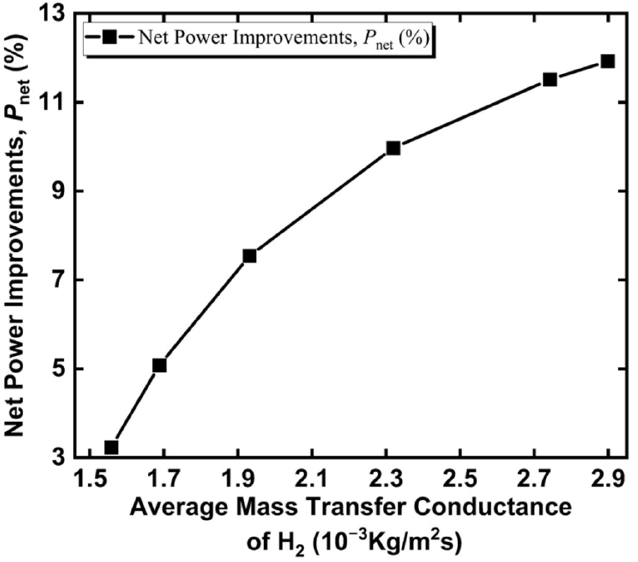
Figure 13. The percentage of the net power improvements as a function of the average mass transfer conductance of H 2 .